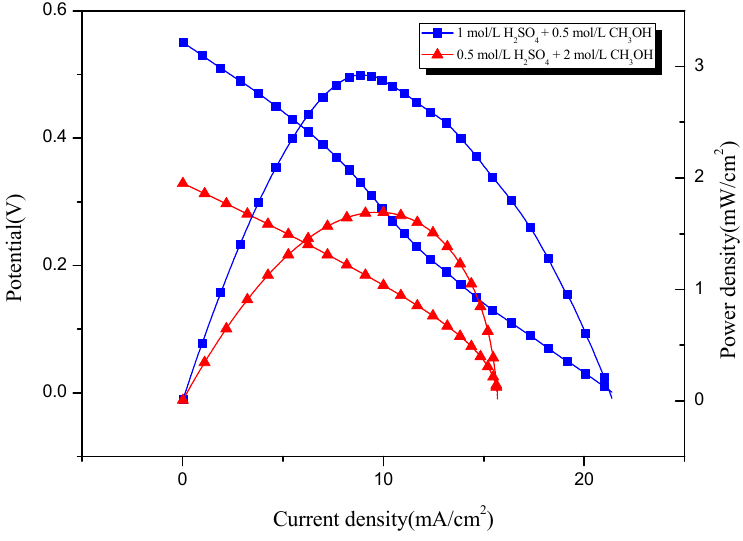
Figure 9. Polarization curves of the DMFC in different electrolytes.